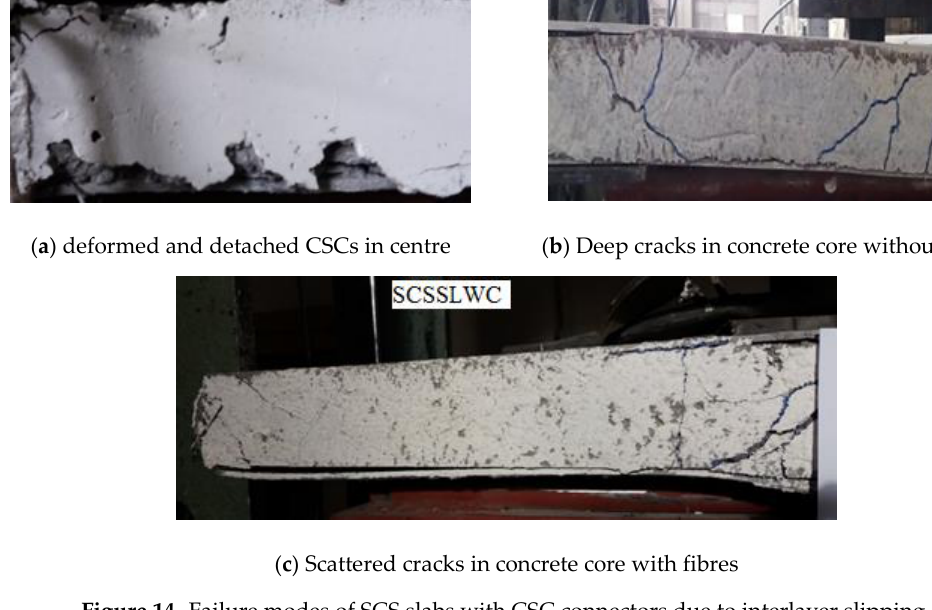
Figure 14. Failure modes of SCS slabs with CSC connectors due to interlayer slipping.